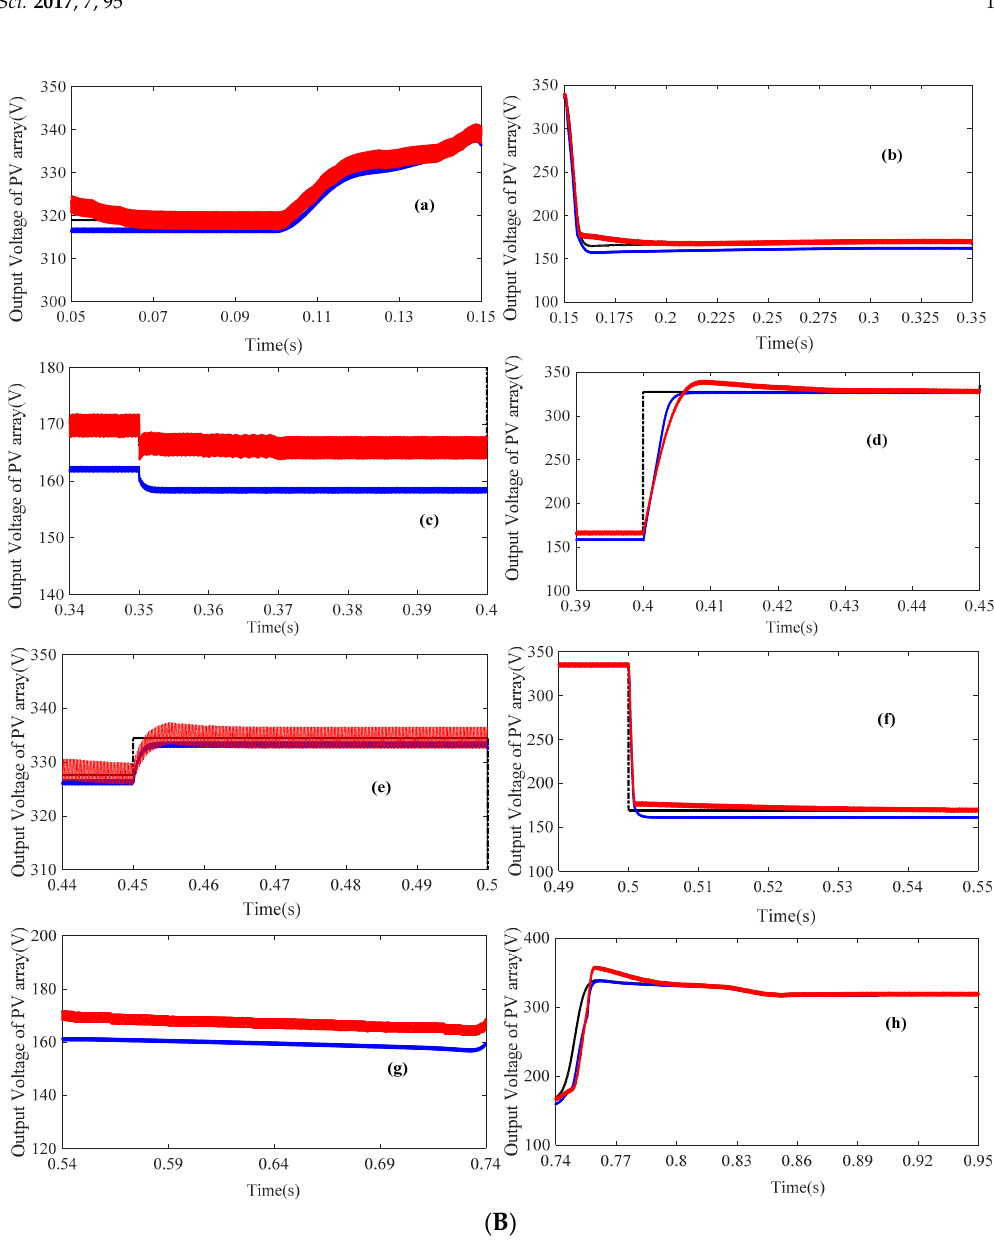
Figure 10. Output voltage of PV systems with AFL (augmented state feedback precise linearization) and FL (state feedback precise linearization) controller: ( A ) Output voltage (overall); ( B ) output voltage (detailed): ( a ) output voltage (0.05–0.15 s); ( b ) output voltage (0.15–0.35 s); ( c ) output voltage (0.35–0.40 s); ( d ) output voltage (0.40–0.45 s); ( e ) output voltage (0.45–0.50 s); ( f ) output voltage (0.50–0.55 s); ( g ) output voltage (0.55–0.74 s); ( h ) output voltage (0.74–0.95 s).